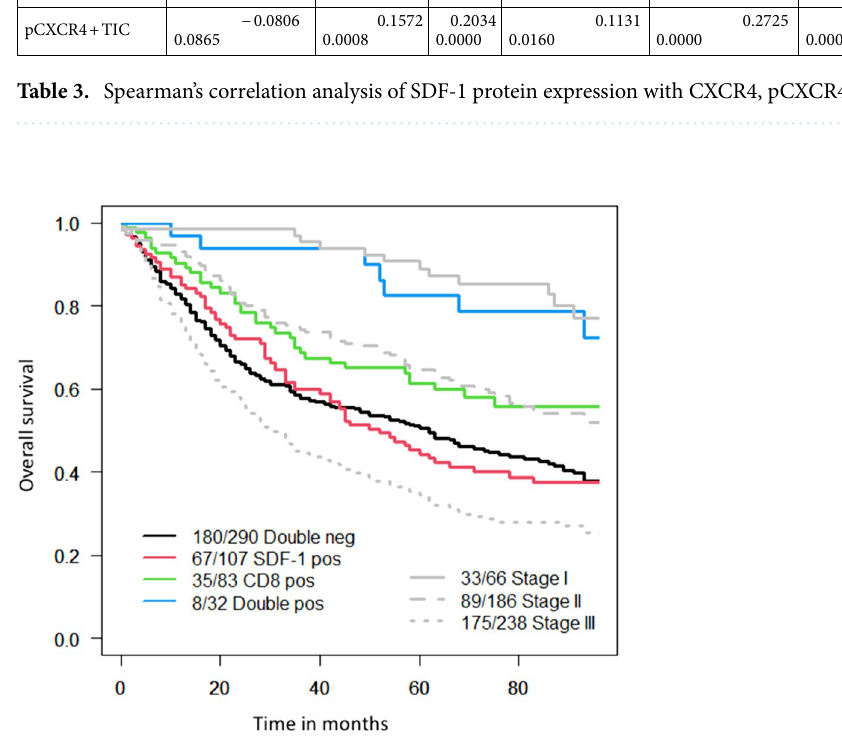
Figure 2. Kaplan–Meier survival curves of the overall cohort with the pairwise comparisons between the different curves. Effects of combined high CD8+ T-cell density and SDF-1 tumor expression on overall survival in patients with CRC. Kaplan–Meier overall survival curves were designed according to SDF-1 tumor expression and CD8+ cell density in patients bearing CRC as indicated. Cut-off values established by regression tree analysis were 200 for SDF-1 and 10 cells/punch for CD8+ cell infiltration 30–32 . Cumulative effects of SDF-1 expression and CD8+ cell density were explored. Black line indicates tumors with low CD8+ T-cell density and low SDF-1 expression. Red line refers to tumors with low CD8+ T-cell density and high SDF-1 expression. Green line indicates tumors with high CD8+ T-cell density and low SDF-1 expression. Blue line refers to tumors with high CD8+ T-cell density and high SDF-1 expression. In each curve is also represented in the background the overall survival according to the stage (light grey). Stage I is represented with a solid line, stage II with a dashed line and stage III with a dotted line. The pairwise comparisons between the different curves showed the following p-values: SDF-1 negative /CD8 negative (black) versus SDF-1 negative /CD8 positiv (green) p = 0.015. SDF-1 negative / CD8 negative (black) versus SDF-1 positive /CD8 negative (red) p = 0.89. SDF-1 negative /CD8 negative (black) versus SDF-1 positive / CD8 positiv (blue) p = 0.001. SDF-1 positive /CD8 negative (red) versus SDF-1 negative /CD8 positiv (green) p = 0.020. SDF-1 positive / CD8 negative (red) versus SDF-1 positive /CD8 positiv (blue) p = 0.001. SDF-1 negative /CD8 positive (green) versus SDF-1 positive / CD8 positiv (blue) p =